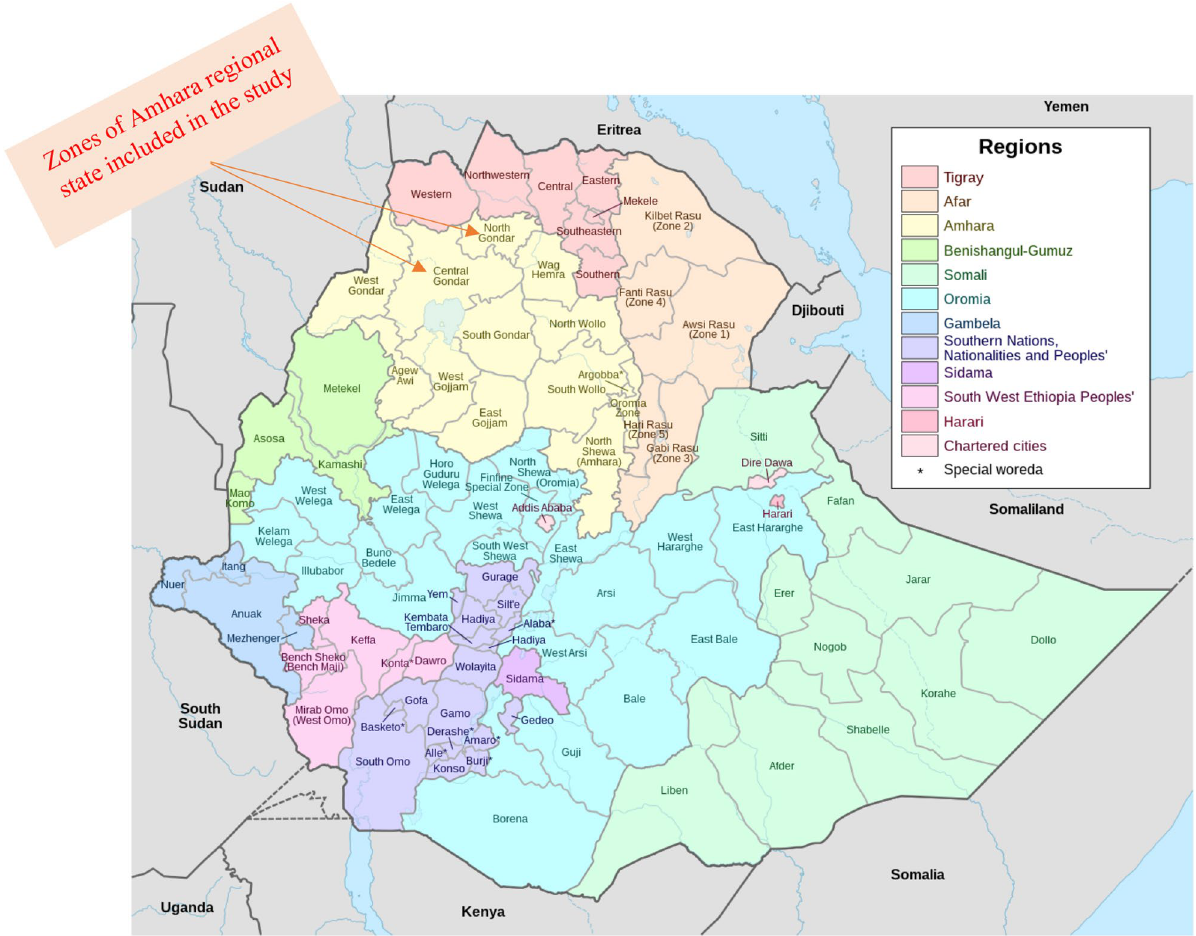
Figure 1. Map of study areas (Source: https:// en. wikip edia. org/ wiki/ List_ of_ zones_ of_ Ethio pia#/ media/ File: Map_ of_ zones_ of_ Ethio pia.